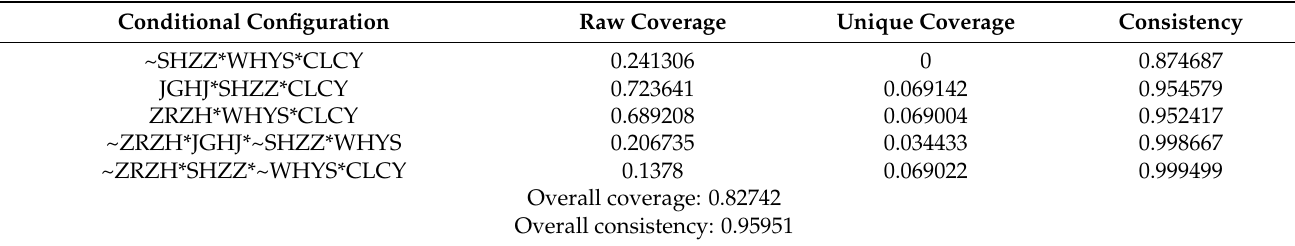
Table 9. Intermediate solution.